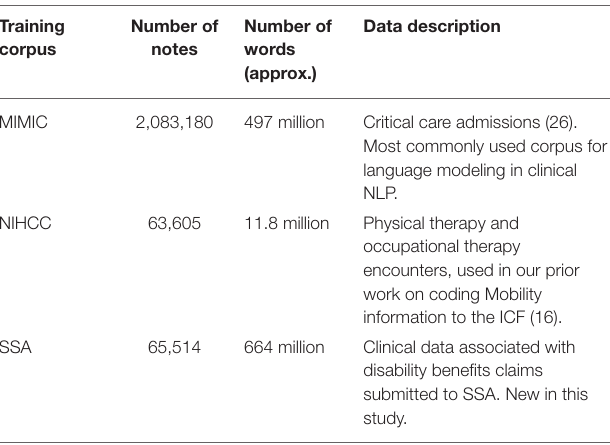
TABLE 1 | Free text corpora used to train word embedding models for text